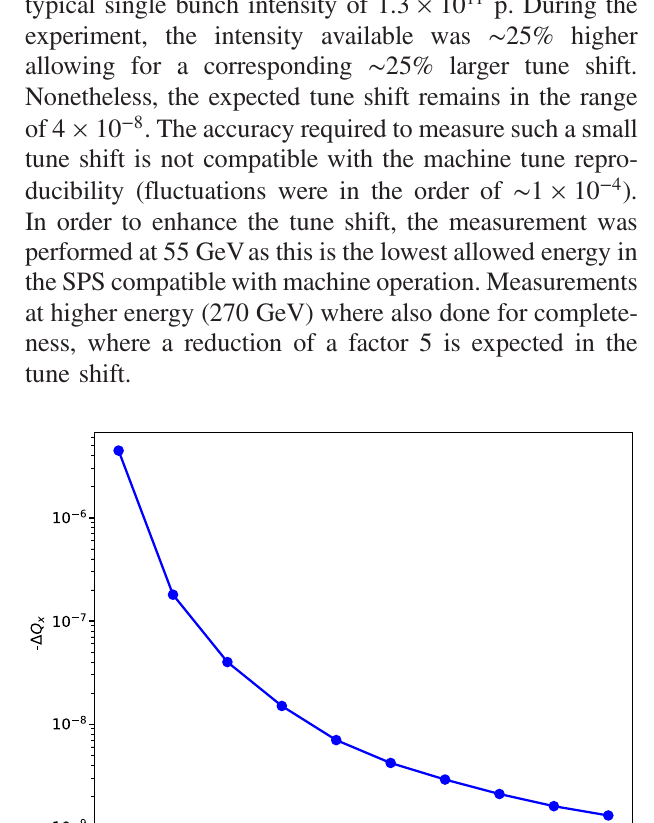
¼ 4 σ ¼ 3 b rms